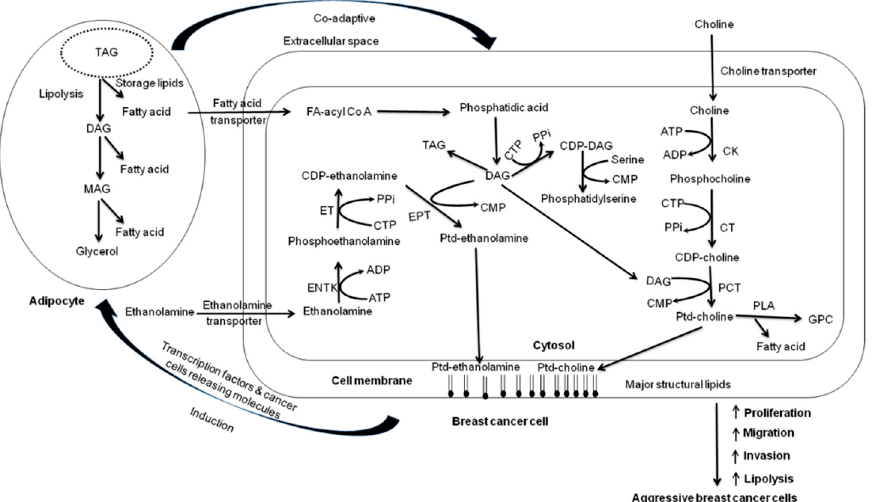
Figure 2. Metabolic reprogramming in breast cancer cells, its role, and the induced co-adaptive mechanism (Reproduced with permission from John Wiley & Sons, Inc. from Reference [44])